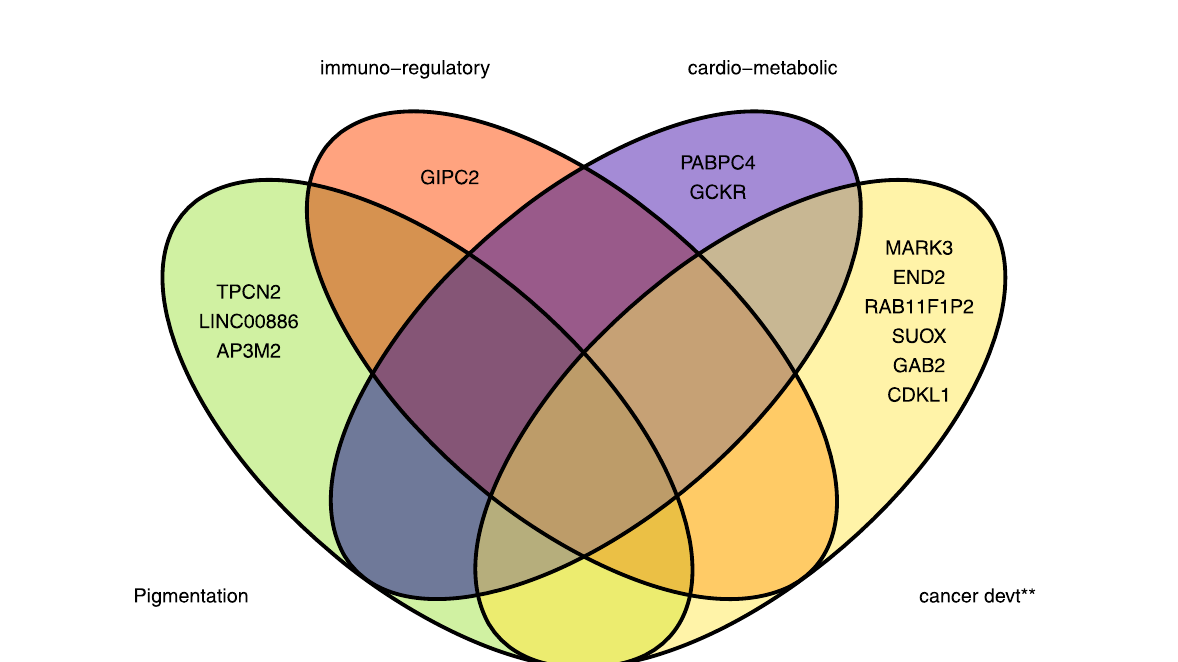
Fig. 6 | Squamous cell carcinoma loci and biological pathways. The broad bio- logicalpathwaysincluded;pigmentation,immuno-regulatory,cardiometabolicand